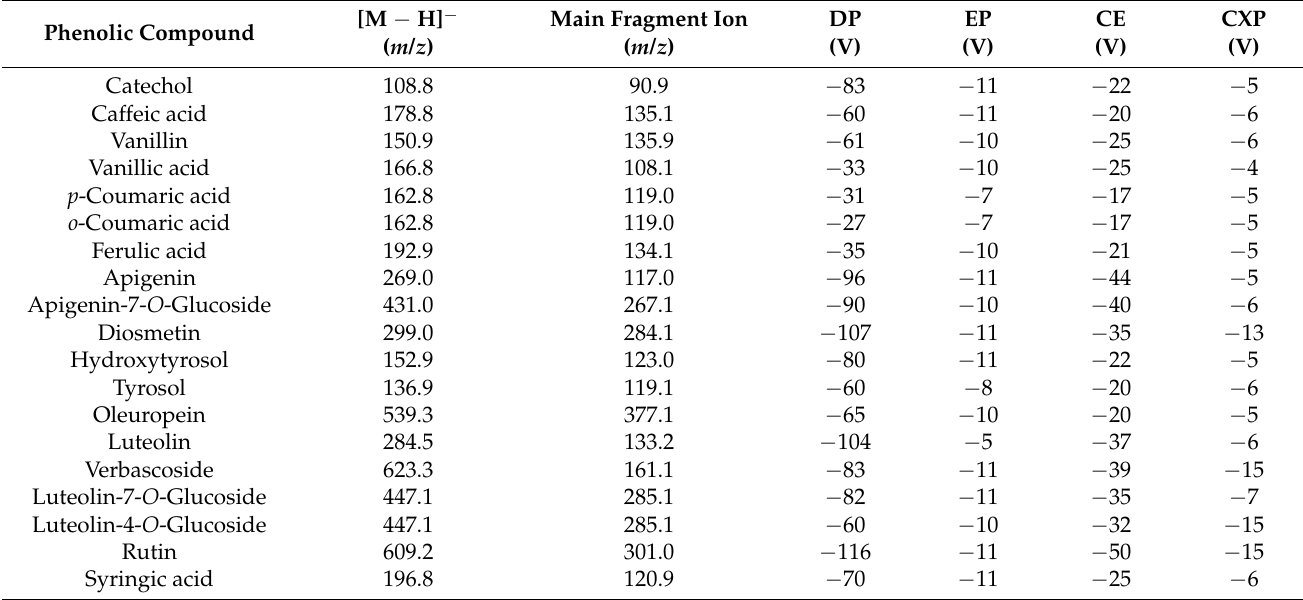
Table 1. LC-MS/MS analysis parameters for the phenolic compounds under investigation including molecular ion [M − H] − monitored on the first quadrupole; main fragment ion selected on the third quadrupole ( m / z ); declustering potential (DP); entrance potential (EP); collision energy (CE) and cell exit potential